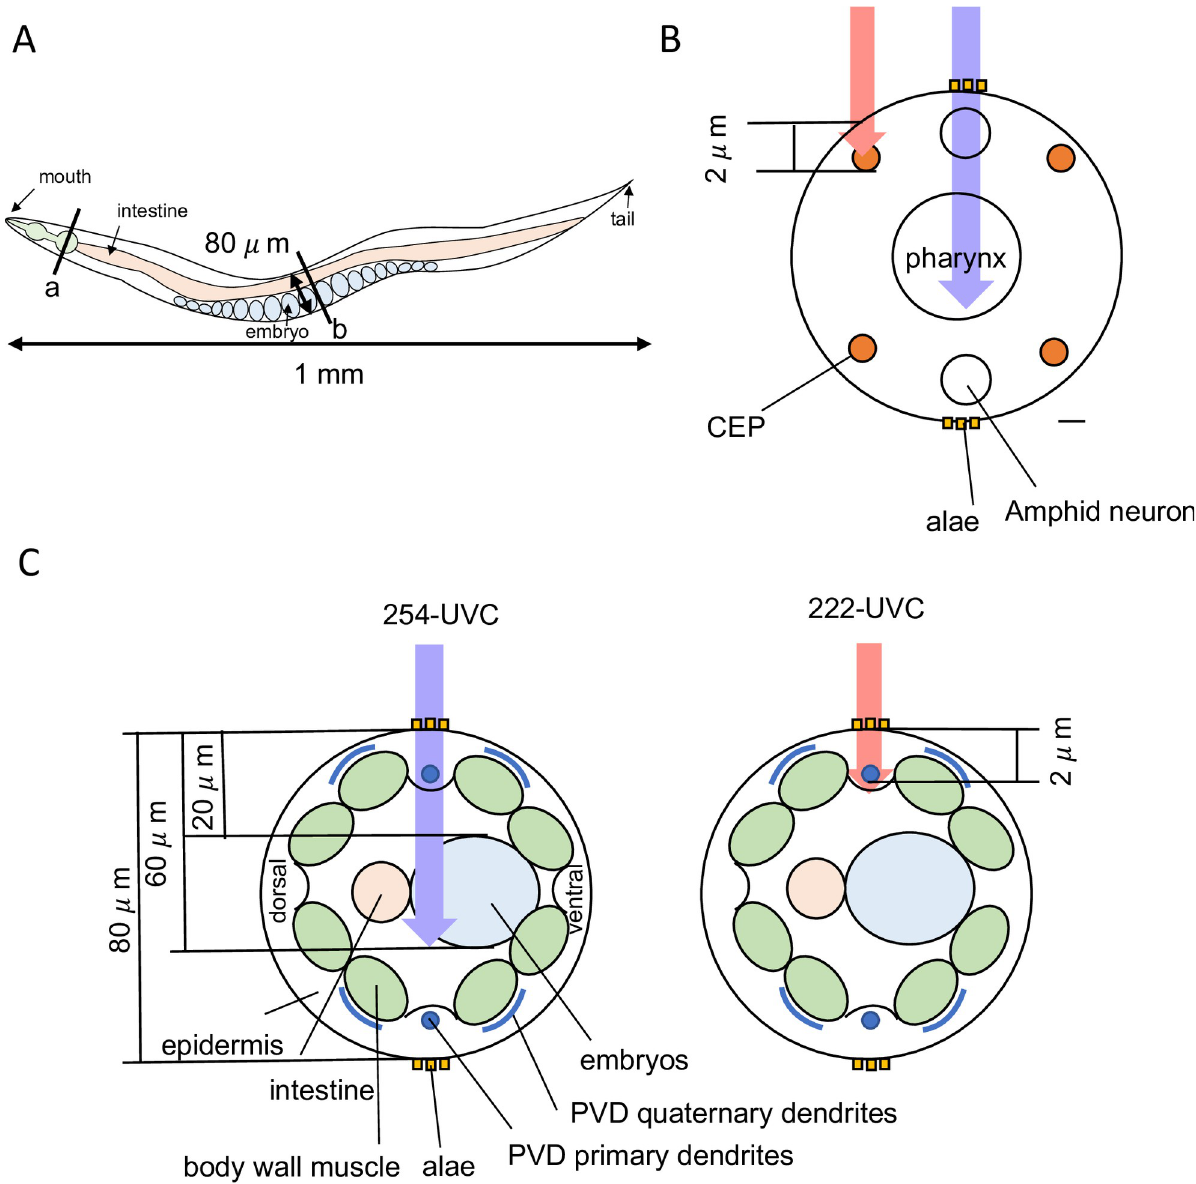
Fig 6. C . elegans structure. (A) C . elegans body plane, showing the side view. (B) Head section of C . elegans (cross section of “a” in Fig 6A). Orange circles show CEP neurons. Scale bar, 1.0 μ m. (C) Cross-section of the midbody region (cross section of “b” in Fig A). Blue circles and lines show PVD neurons. Purple and pink arrows show 254- and 222-UVC, respectively. Images modified from those found at www.wormatlas.org. Altun, Z.F., L.A. Herndon, C. Crocker, R. Lints, and D.H. Hall (eds), 2002–2015 WormAtlas. Available at: http://www.wormatlas.org. If this idea is correct, neurodegeneration may be observed when worms are exposed to high doses of 254-UVC. To test this hypothesis, TG2435 pdat-1 ::GFP was irradiated with 2000 or 4000 J/m 2 of 254-UVC. As expected, a similar increase in the number of puncta was observed 4 h after 2000 and 4000 J/m 2 254-UVC irradiation as with 200 or 400 J/m 2 222-UVC irradia- tion (Fig 8A and 8B). These observations indicate that neurons on the body surface do not absorb as much energy as 222-UVC unless the dose of 254-UVC is increased. This result